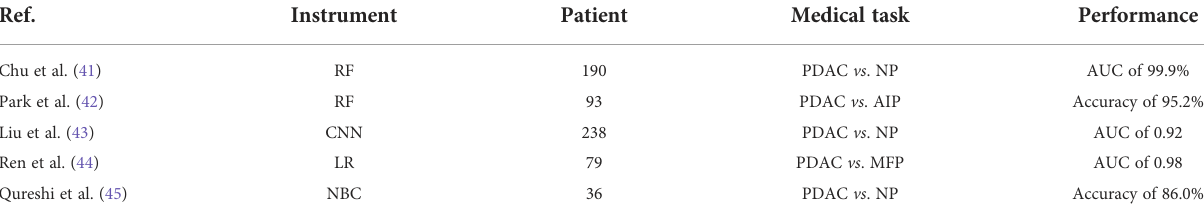
TABLE 5 Diagnosis of pancreatic cancer by computerized tomography.